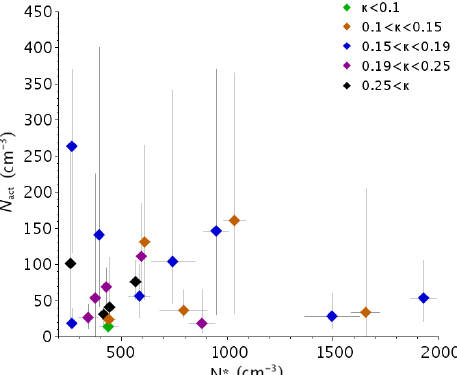
Figure 10. Median values for the 23 fog events of the number concentration measured by the CCN chamber at SS = 0 . 1% as a function of the concentration of aerosol particles with diameter > 200nm. Color as a function of κ is indicated as in Fig. 8. Symbol size is proportional to the mean diameter.